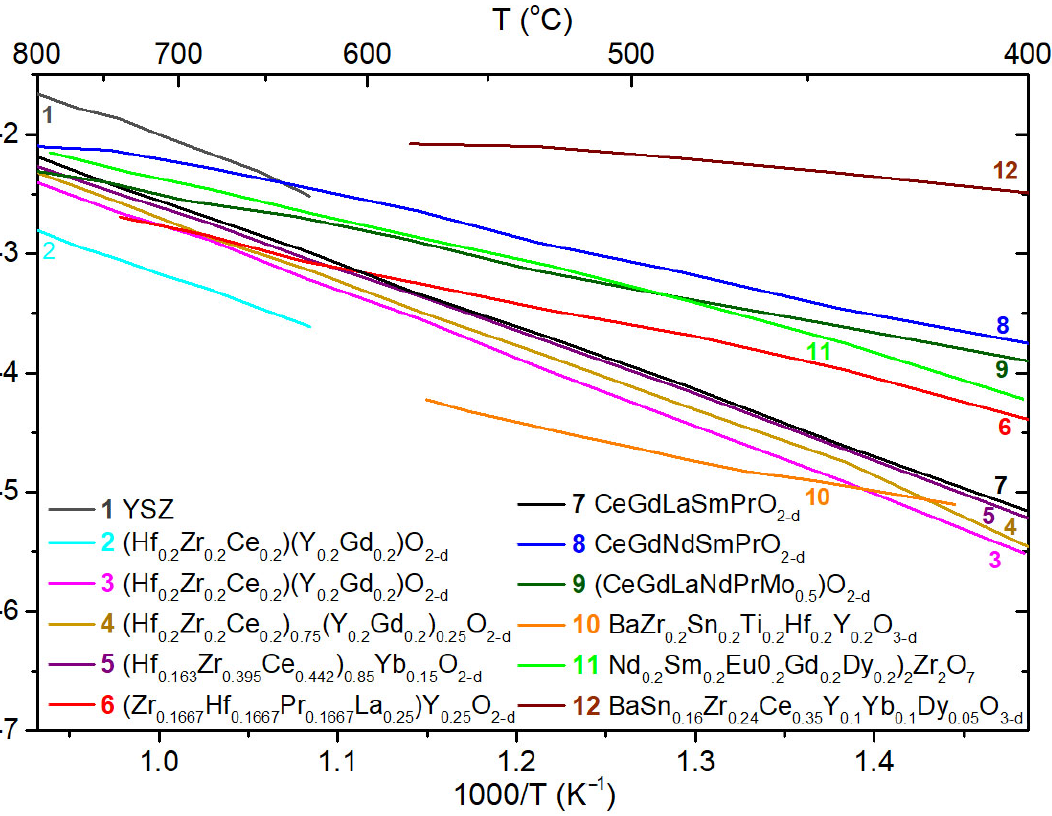
Figure 14. Arrhenius dependences of total conductivity of HEO-based solid-state electrolytes (con- structed using the data: 1, 2 [163], 3, 4, 5 [165], 6 [14], 7 [173], 8, 9 [174], 10 [12], 11 [171], 12 [175]).